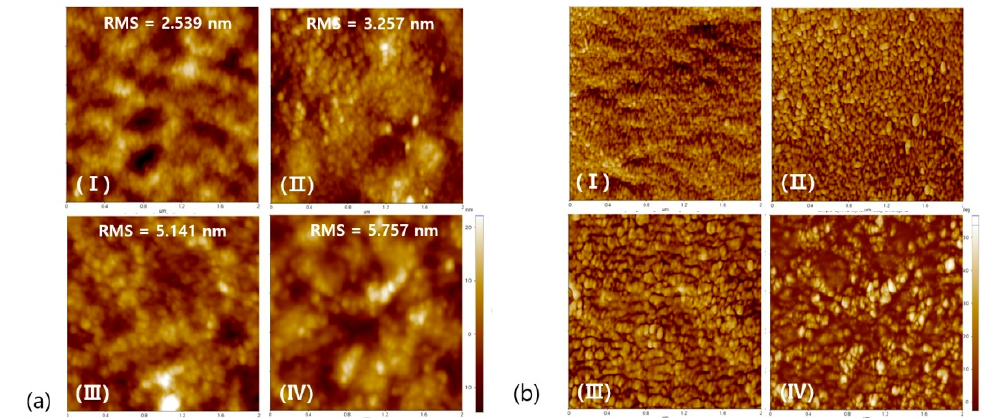
Figure 7. AFM image of ( a ) surface morphology and ( b ) phase shift of PEDOT:PSS films undoped (I), doped (II) with DMSO, PEDOT:PSS-C6 film undoped (III), and doped (IV) with DMSO.